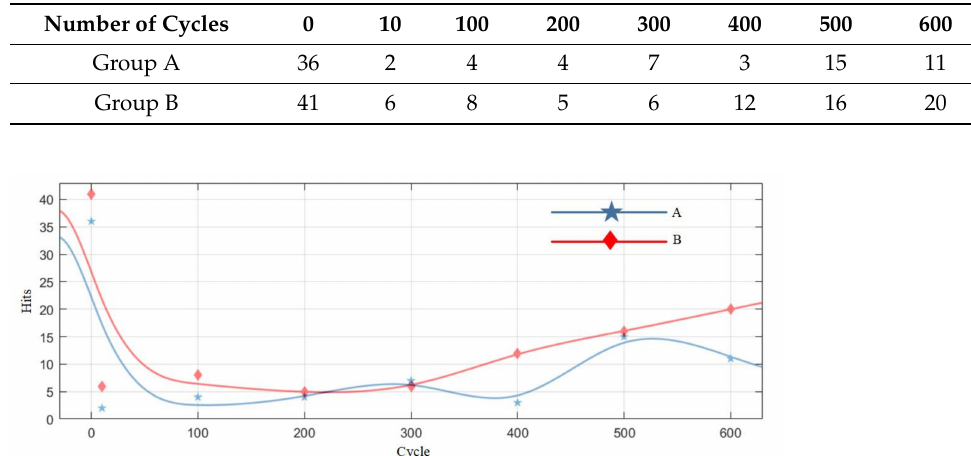
Table 7. Statistics of the number of pulse acoustic emission signals.